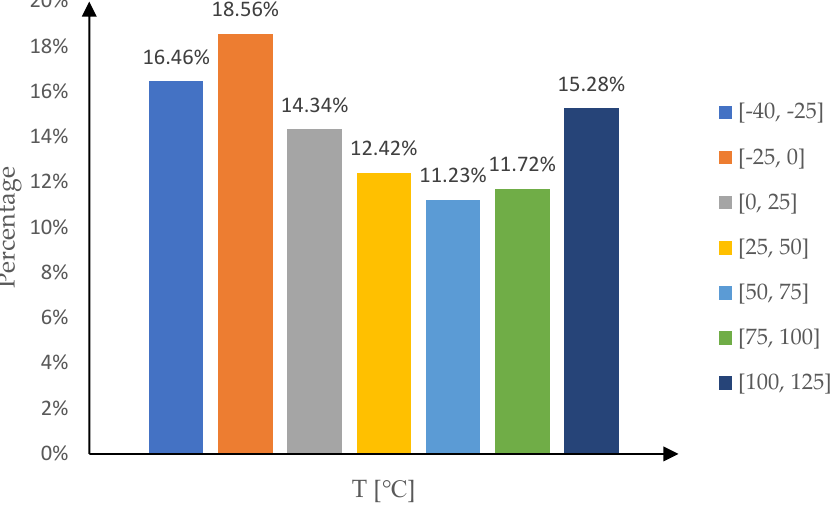
Figure 4. Temperature distribution of the training data with an RE greater than μ + 3 σ . The training data with an RE greater than μ + 3 σ accounted for 0.89% of all training data.